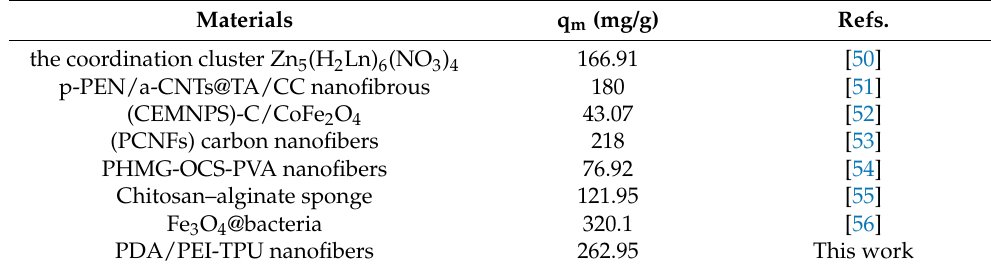
Table 4. Summary of adsorption capacities of CR on different nanofiber adsorbents or others.